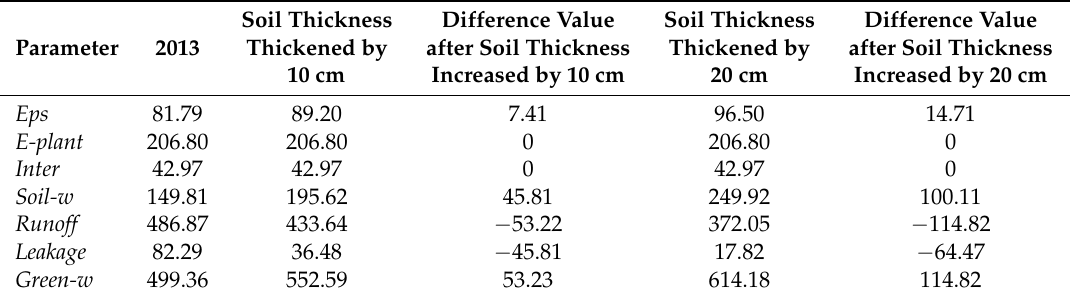
Table 9. Main indices of blue water and green water variation with different soil thickness (unit: mm).